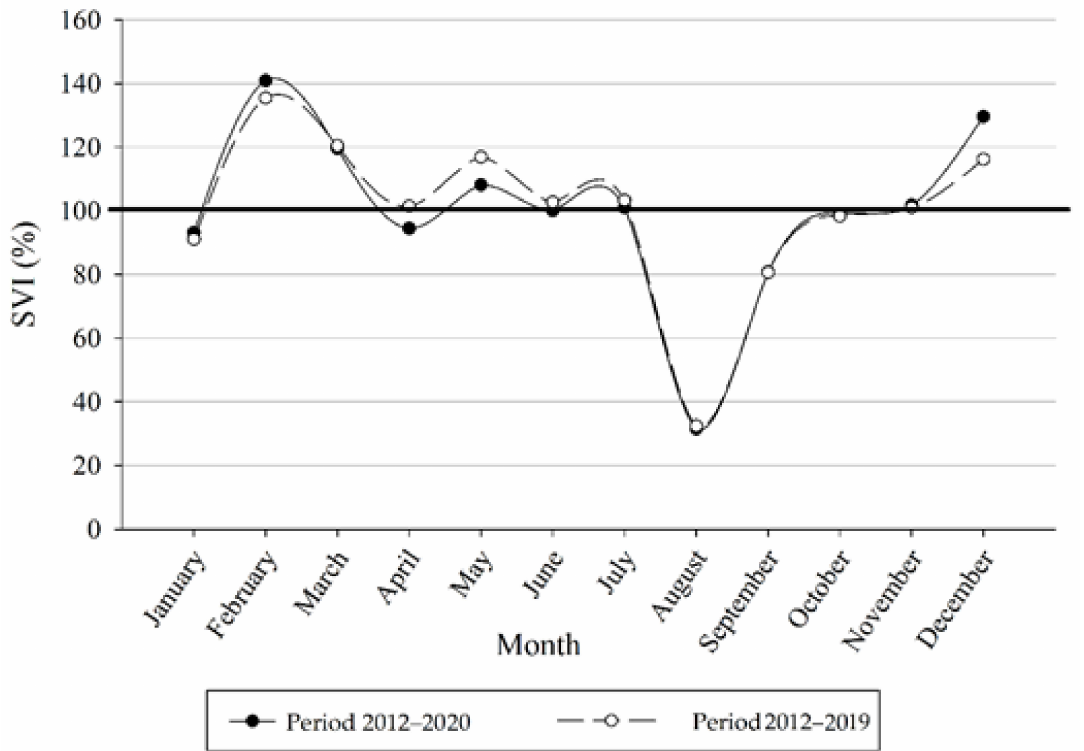
Figure 11. Seasonality pattern of vehicle disembarking traffic of the port of Pasajes during the periods 2012–2019 and